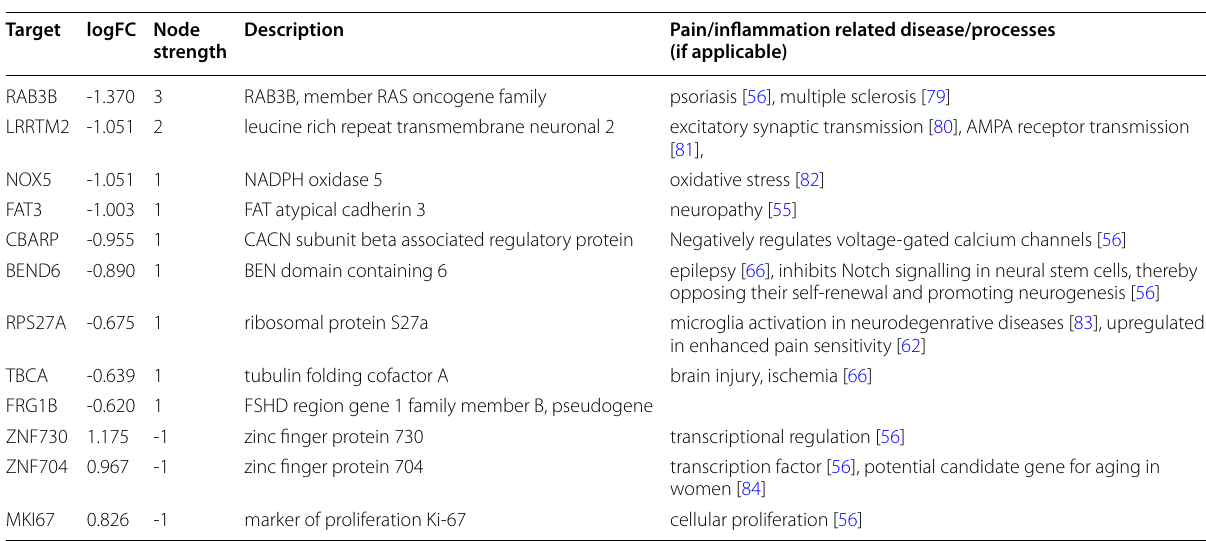
Table 9 Common targets, with similar changes in mRNA- and small RNA sequencing data for validation of predictions at mRNA level in ictal vs interictal comparison. Description and pain phenotype matches based on Human Pain Gene [53], Pain Research Forum [54], DisGeNET [55], and GeneCards [56], complemented with other literature data. logFC: logarithm of the fold change of measured